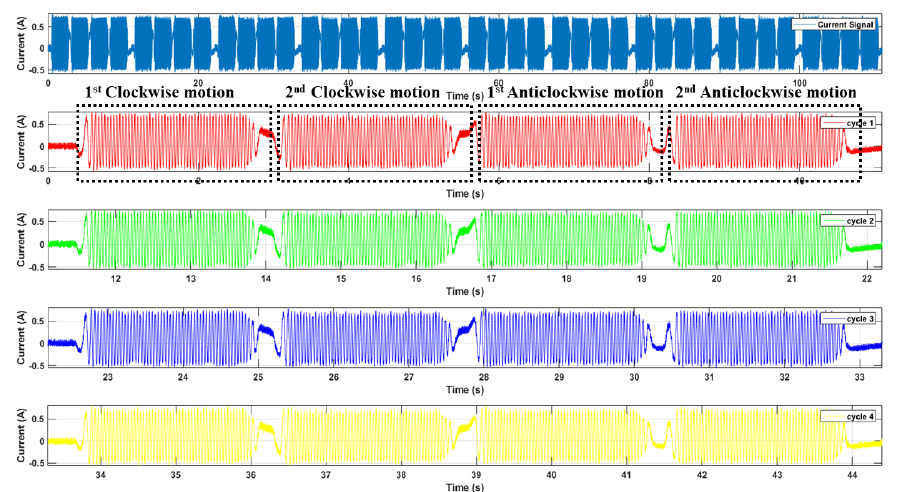
Figure 13. An example of segmented cycles for the signal shown in Figure